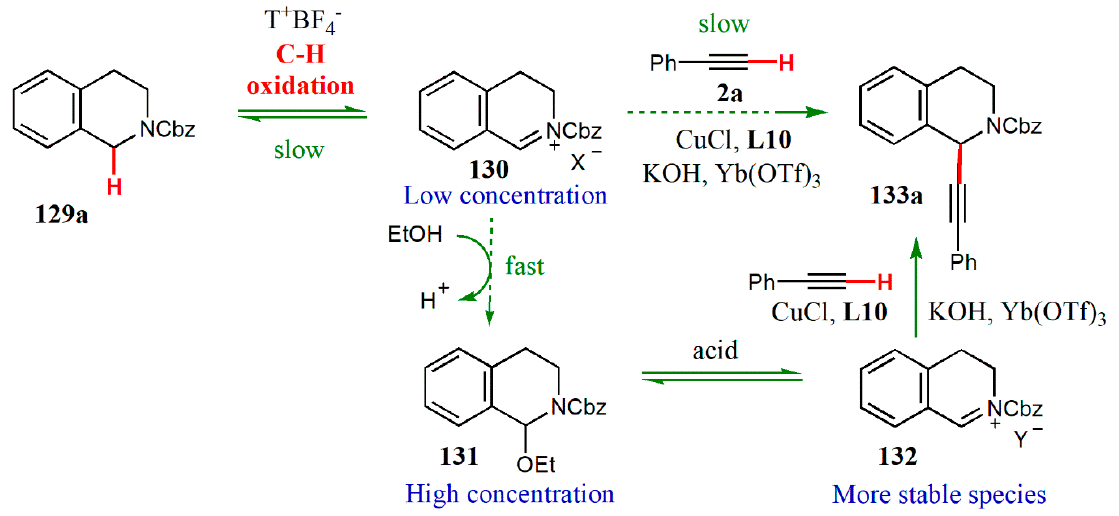
Figure 41. Enantioselective CDC of Cbz-protected THIQs. Proposed mechanistic role of EtOH as additive.